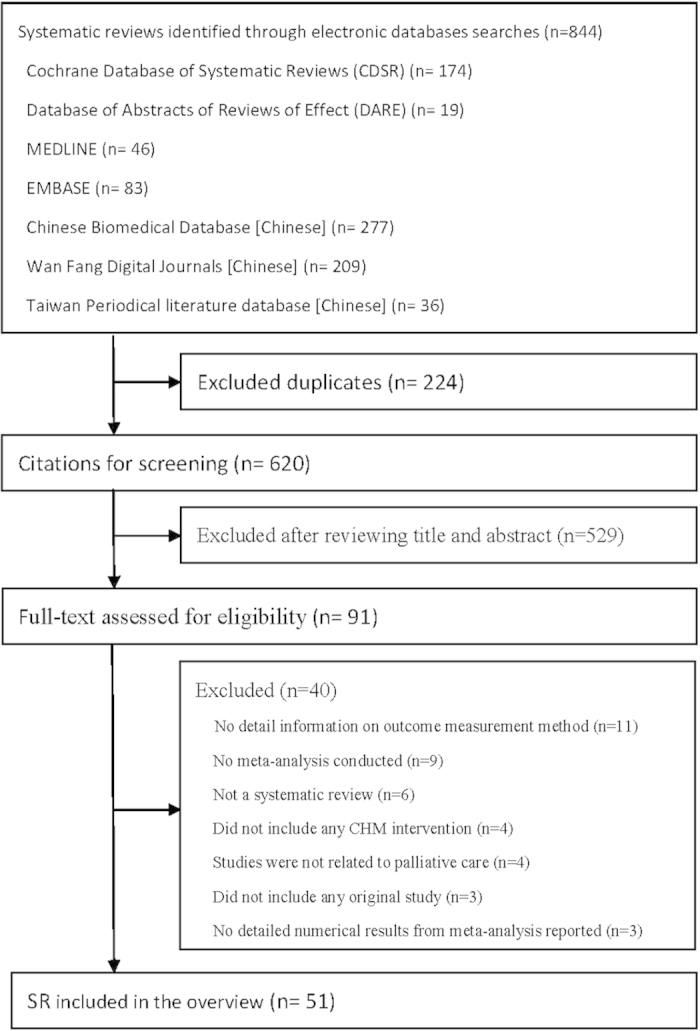
Flowchart of literature selection on meta-analyses of Chinese herbal medicines for cancer palliative care. Keys: CHM, Chinese herbal medicine; SR, systematic review.